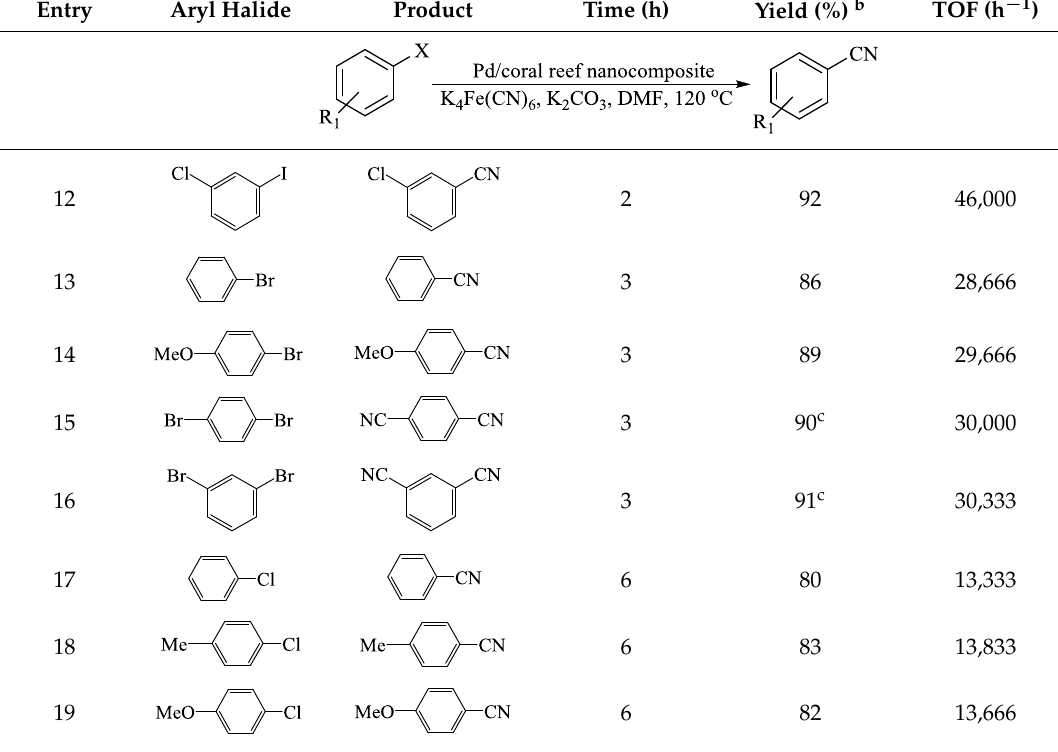
a Reaction conditions: Catalyst (0.05 g containing 0.001 mol% of Pd), aryl halides (1.0 mmol), K 4 Fe(CN) 6 (0.2 mmol), K 2 CO 3 (1.0 mmol), DMF (5.0 mL), 120 °C; b Isolated yields are after work-up; c The reaction was carried out in the presence of 0.4 mmol of K 4 Fe(CN) 6 .